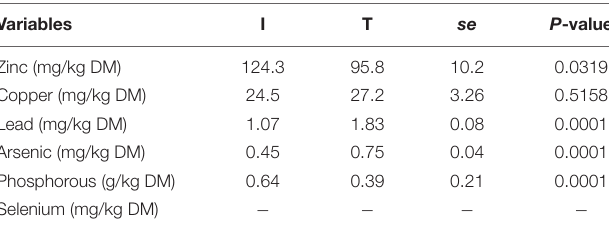
TABLE 1 | Minerals concentration from cattle feces of I (semi-intensive) and T (traditional) beef production systems. Variables